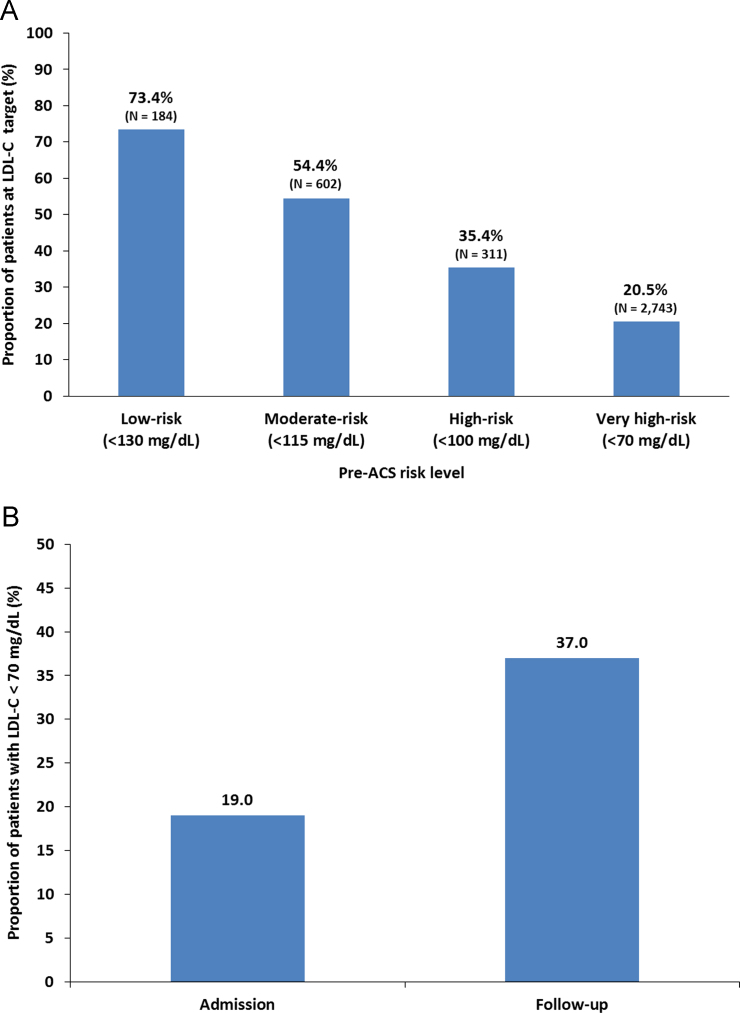
LDL-C target attainment for ACS cohort. (A) LDL-C target attainment by pre-ACS risk level (ESC/EAS guidelines); (B) Proportion of ACS patients with an LDL-C level of <70 mg/dL at hospital admission and at 120-day follow-up (for patients with values available at both time points, N = 1071).